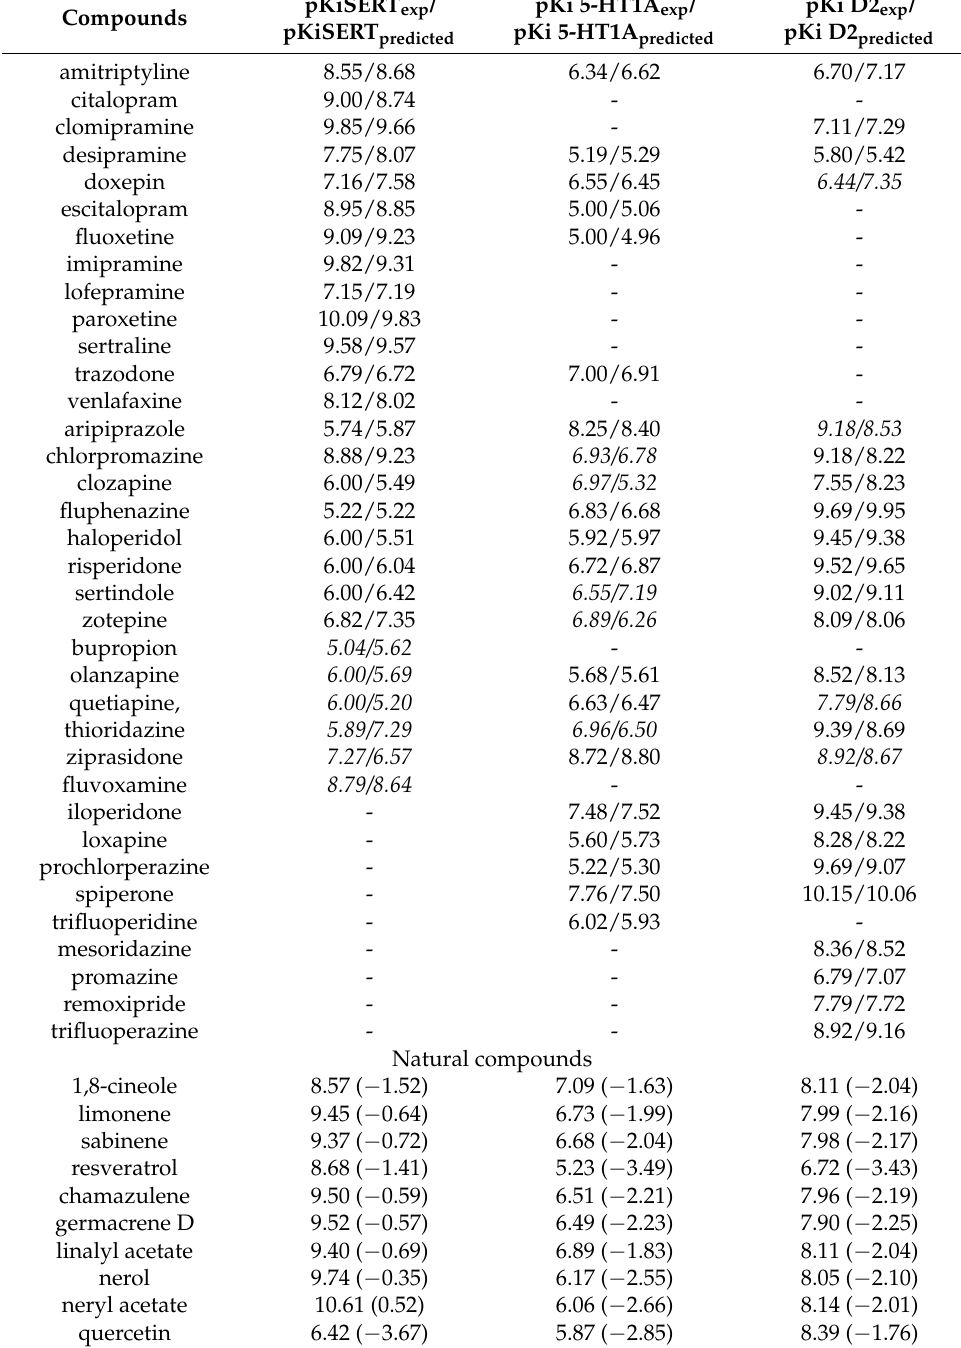
Table 6. Predicted and experimental biological activities of compounds at SERT, 5-HT1A, and D2 receptors. The biological activities of molecules in the validation set are in italics. In brackets are the predicted biological activities of natural compounds versus the most active compounds of each QSAR model (paroxetine in QSAR-SERT; ziprasidone in QSAR-5HT-1A; spiperone in